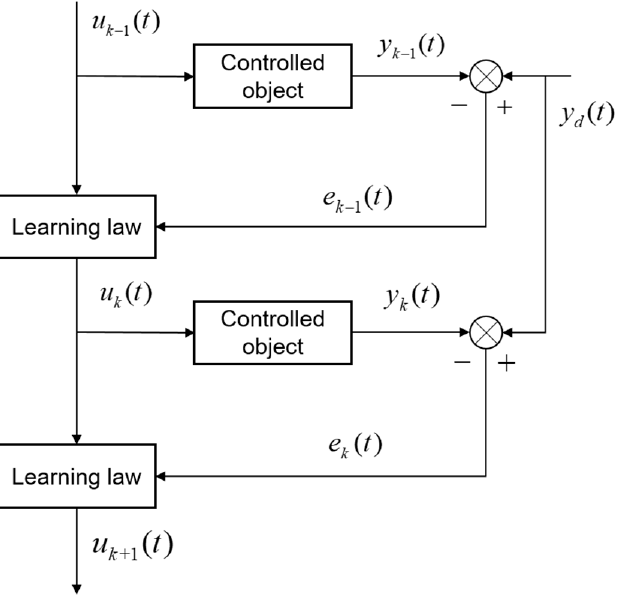
Figure 6. Iterative learning principle of ILC.